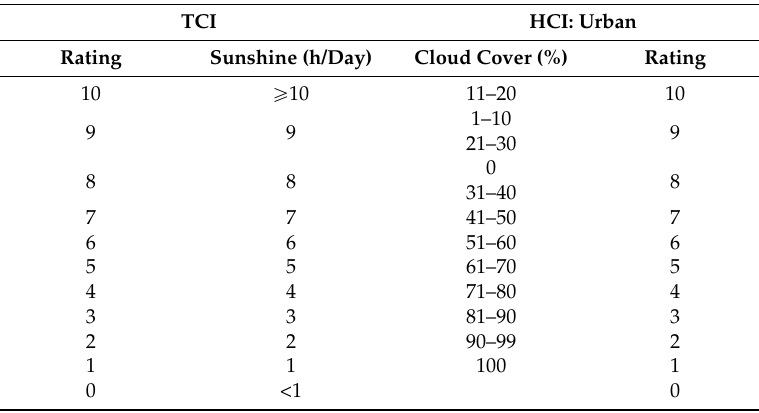
Table 4. Comparison of the aesthetic rating